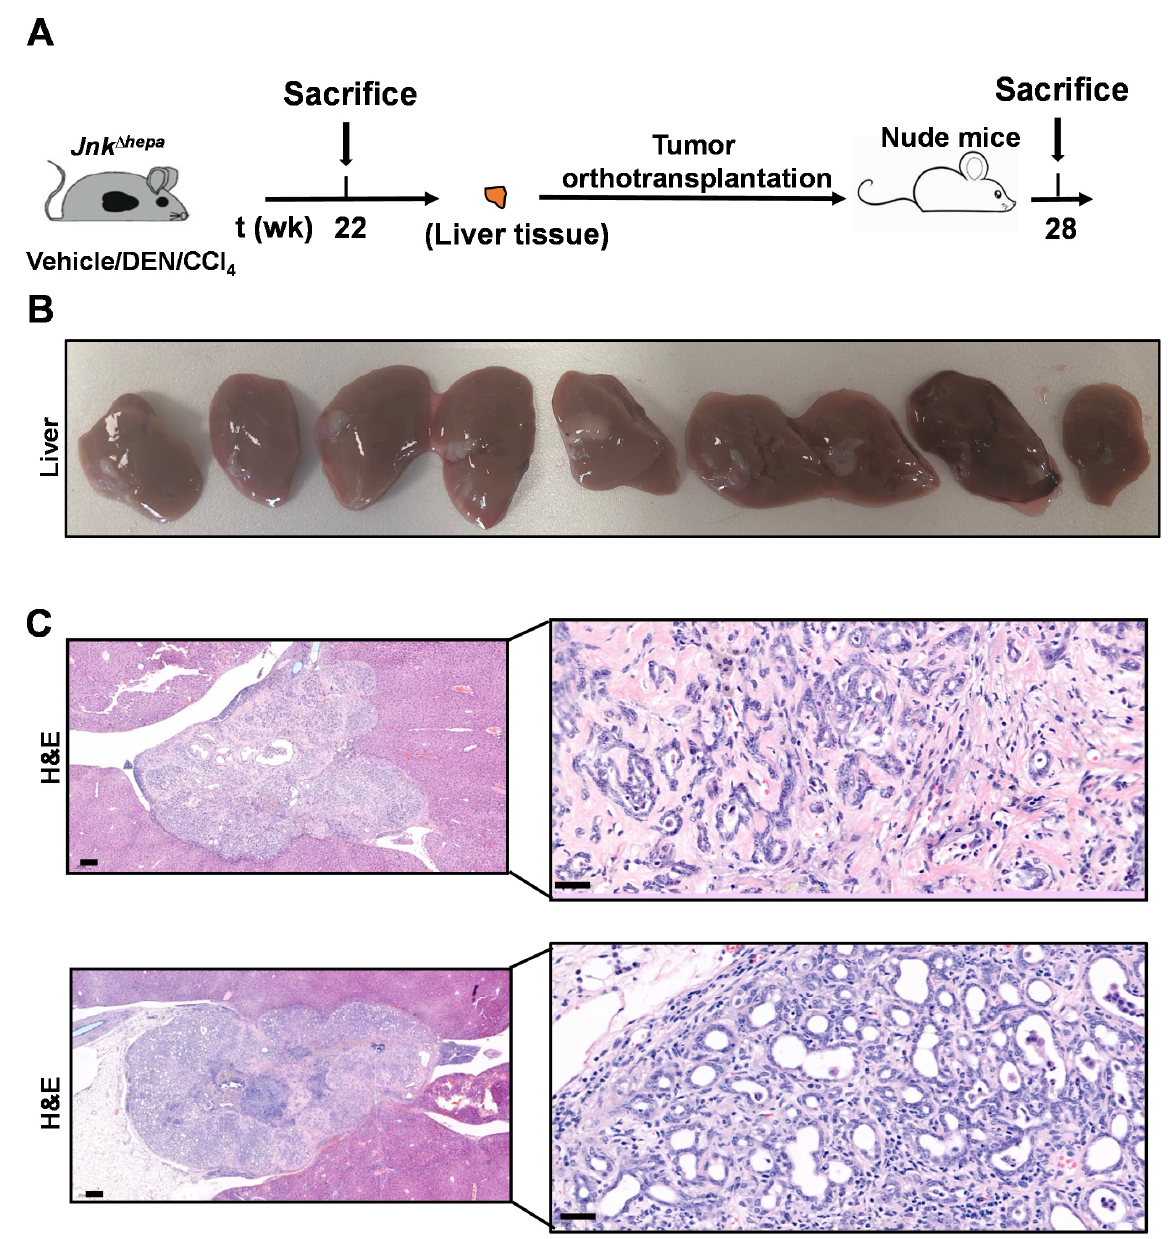
Figure 8. Lesions developed in DEN/CCl 4 treated Jnk ∆ hepa mice are malignant and display CCA histological features. ( A ) Lesions developed in DEN/CCl 4 treated Jnk ∆ hepa mice were excised and orthotopically implanted in nude mice ( n = 9), which were sacrificed and analyzed 28 weeks later. ( B ) Macroscopic aspect of livers from recipient mice after orthotopic implantation of lesions from DEN/CCl 4 treated Jnk ∆ hepa animals. ( C ) H&E stainings of representative tissue sections of orthoallografts growing in the livers of recipient animals. Scale bars, 50 ( left panels ) and 200 ( right panels ) µm, respectively.